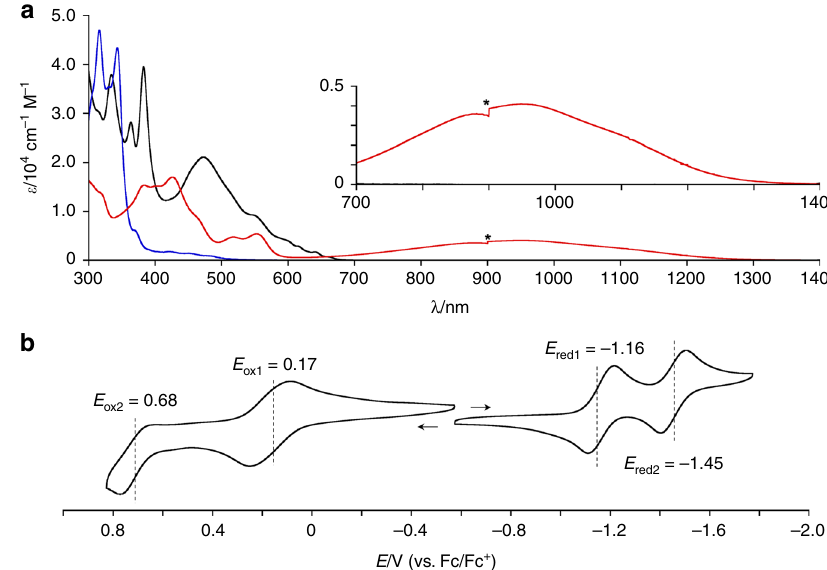
Fig. 3 Narrow HOMO – LUMO gap of as -indacenoterrylenes. a UV/vis/NIR absorption spectra of 3 (red), 7 (blue), and fullerene C 70 (black) in o -dichlorobenzene ( λ : wavelength; ε : extinction coef fi cient). Noise was generated at 900 nm by switching detectors. b Cyclic voltammogram of 2-mesityl- as -indacenoterrylene 9 (solvent: CH 2 Cl 2 ; supporting electrolyte: 0.1 M [Bu 4 N][PF 6 ]; reference electrode: Ag/AgNO 3 ). The second oxidation potential was determined by differential pulse